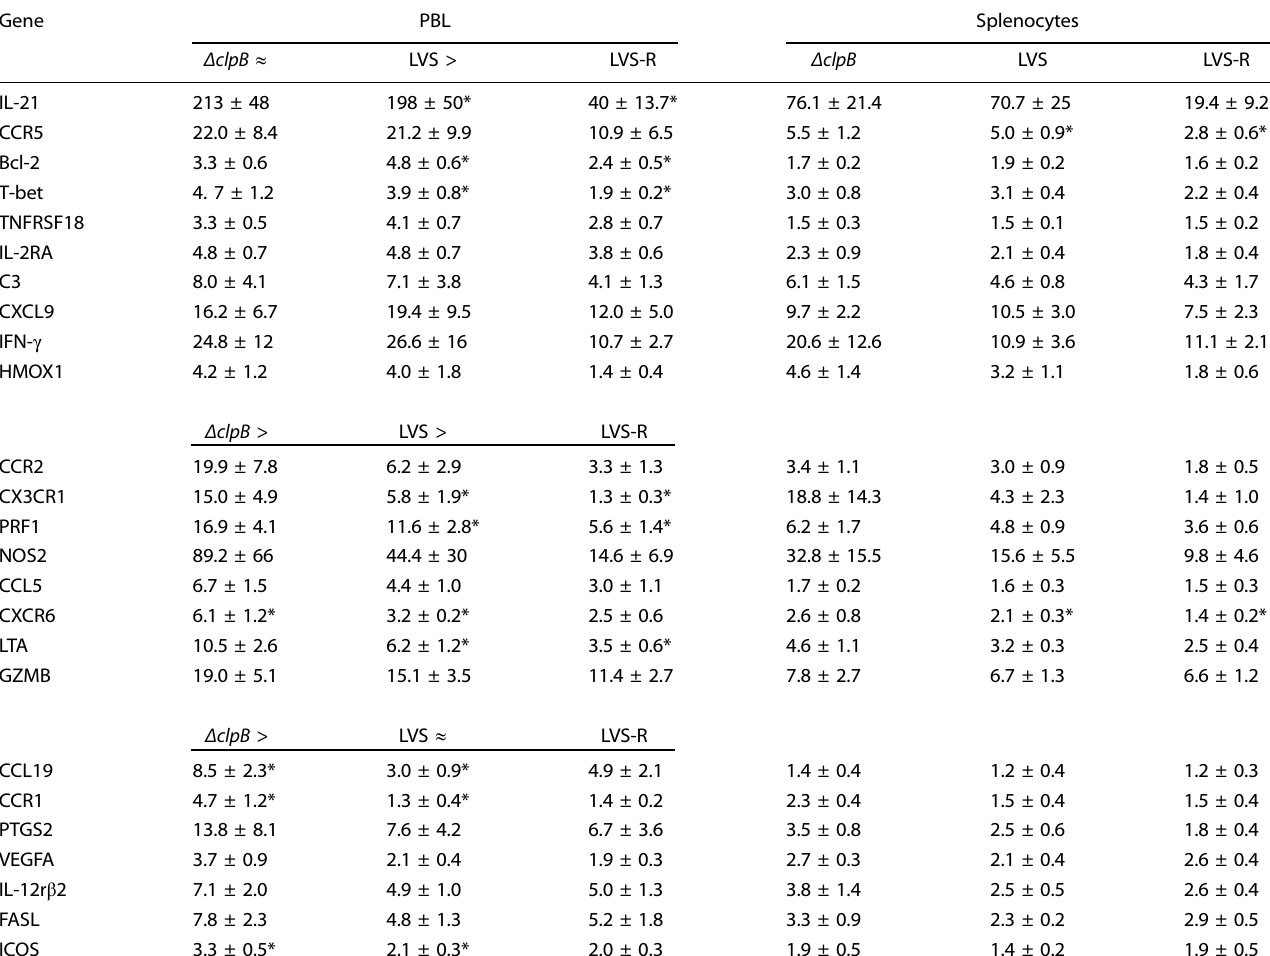
Table 1. Relative gene expression of immune-related factors that correlate with protection in PBLs and splenocytes of C57BL/6 mice recovered from co-cultures at 48 h. Gene PBL